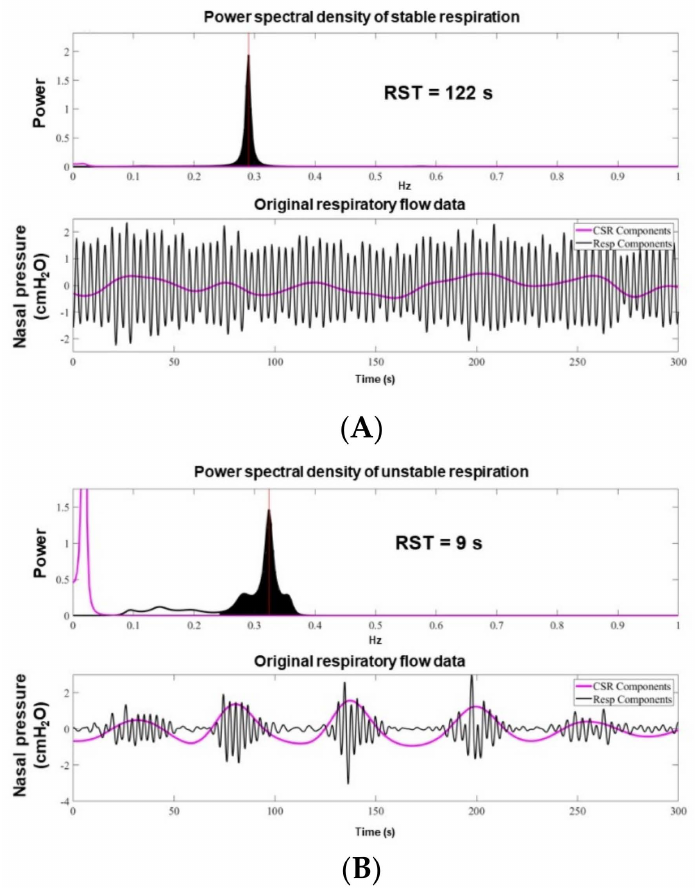
Figure A1. The representation of high RST ( A ) and low RST ( B ). In stable periodic breathing, the frequency spectrum is narrowly distributed and RST is high ( A ). In unstable periodic breath- ing, the spectral components are widely distributed and include very low-frequency components, resulting in a low RST value ( B ).